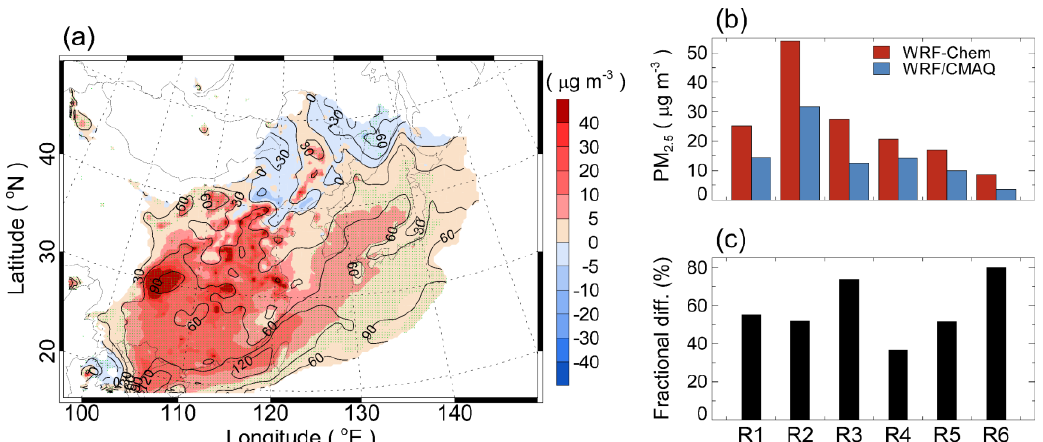
Figure 9. ( a ) Spatial distribution of the concentration difference (shaded) and the fractional difference (line contour) in the surface PM 2.5 concentrations simulated by the WRF-Chem and WRF/CMAQ models, ( b ) mean concentrations and ( c ) fractional differences at each subdivision. Green dots denote the areas where the relative difference is statistically significant within 95%.